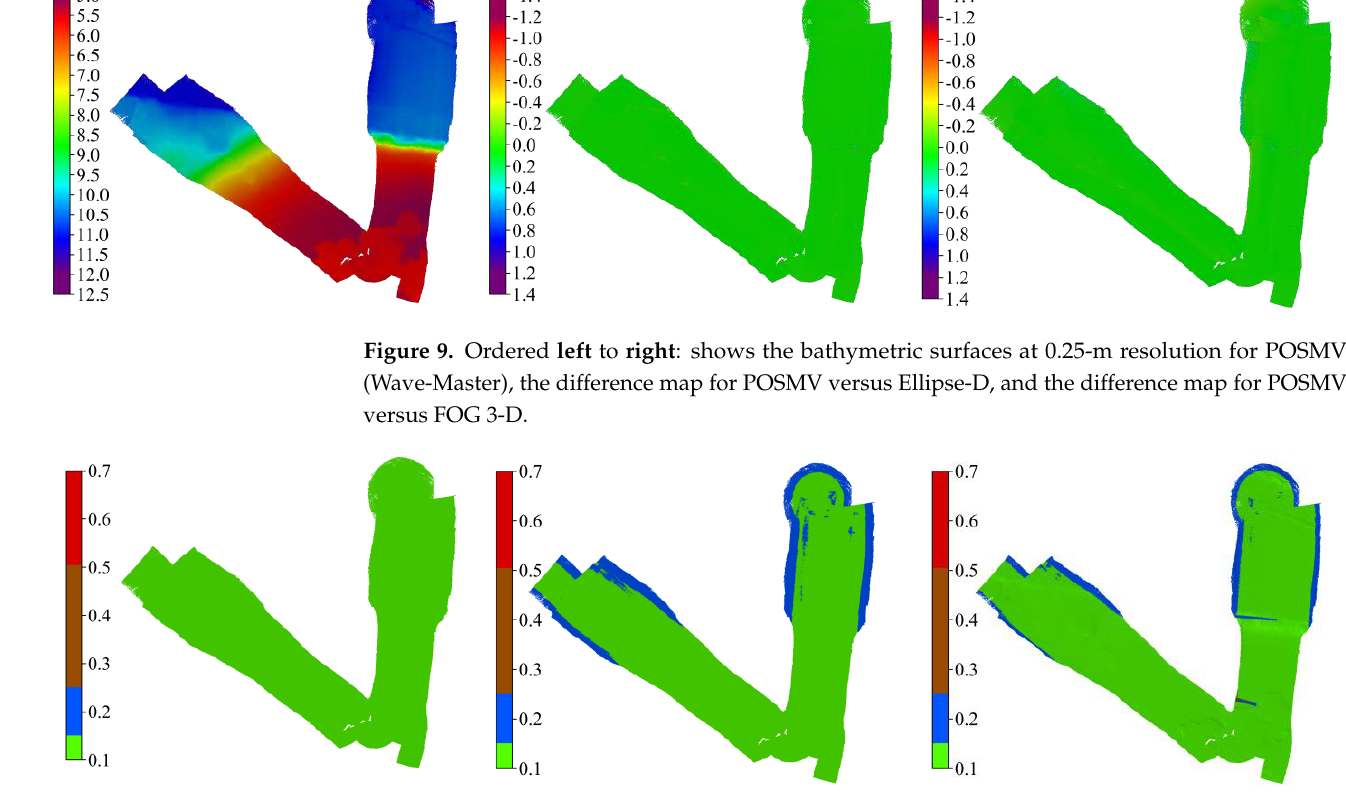
Figure 10. Ordered left to right : shows the TVU surfaces for POSMV, Ellipse-D, and FOG 3-D. The green areas in the lower panel imply TVUs between 0 and 15 cm, and the blue area implies TVUs between 15 and 25 cm.